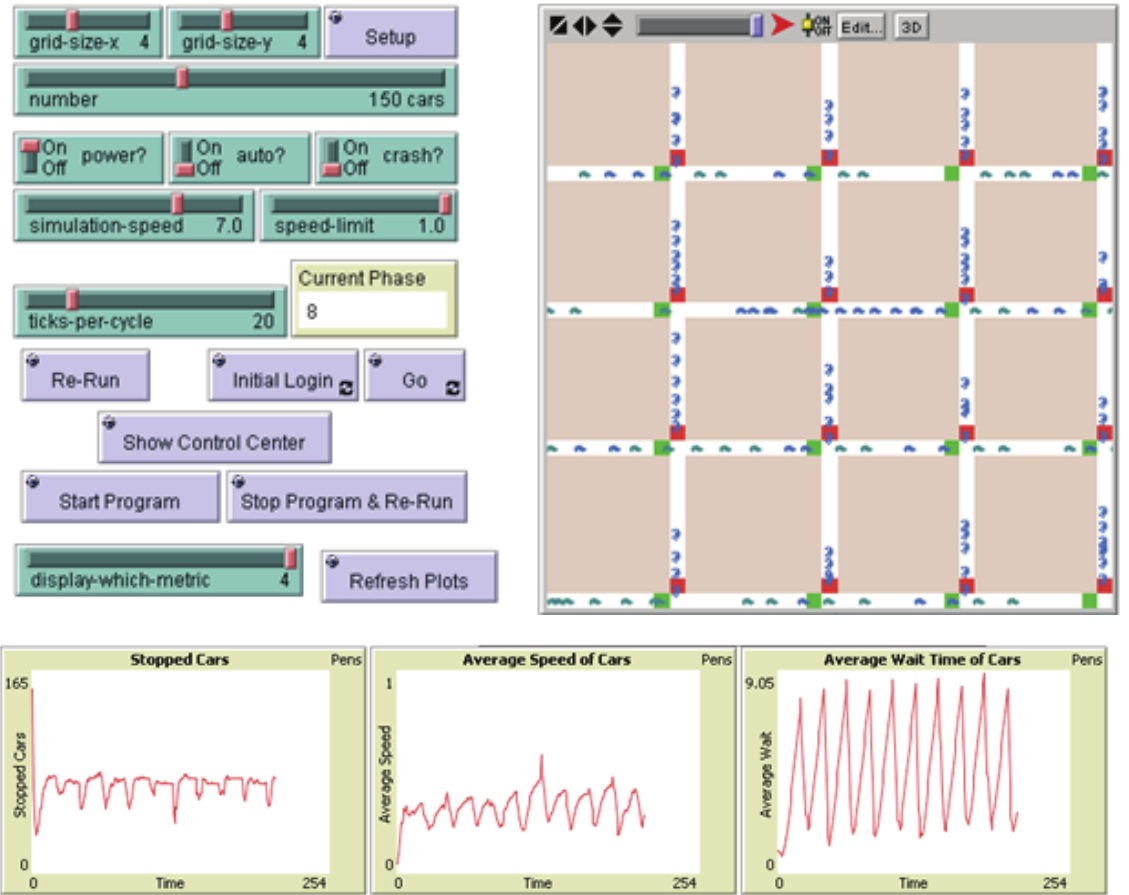
Figure 1: Projected display of the Gridlock participatory